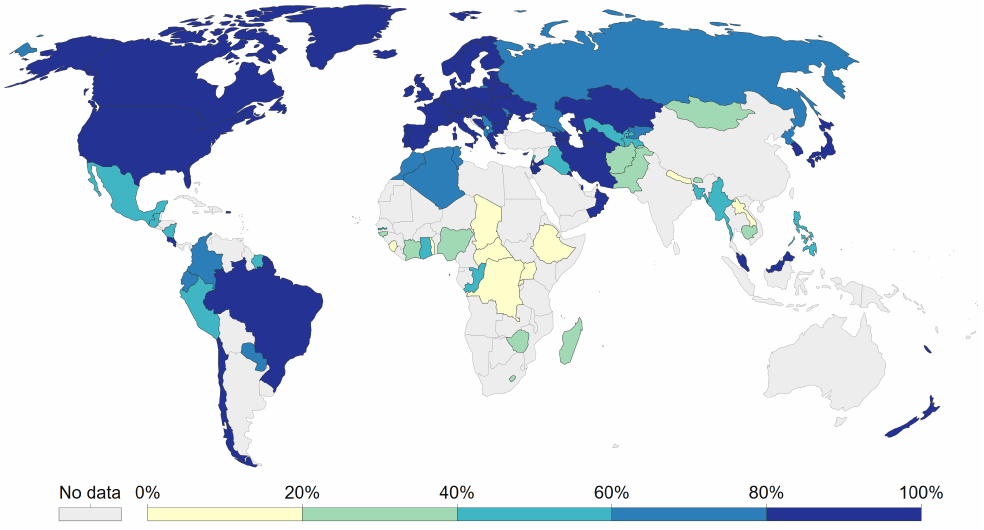
Figure 1. Share of the population with access to safely managed drinking water in 2020